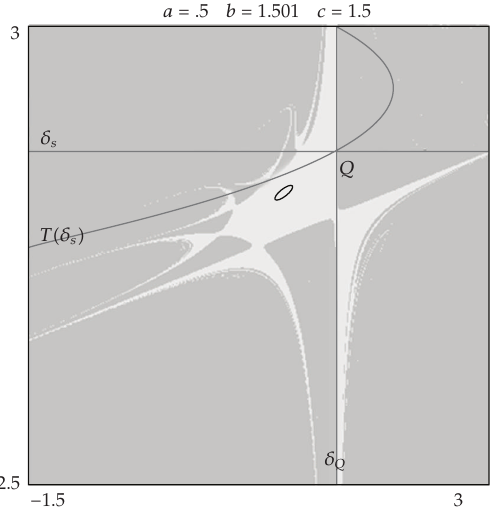
Figure 3: b (cid:2) 1 . 501 basin of attraction